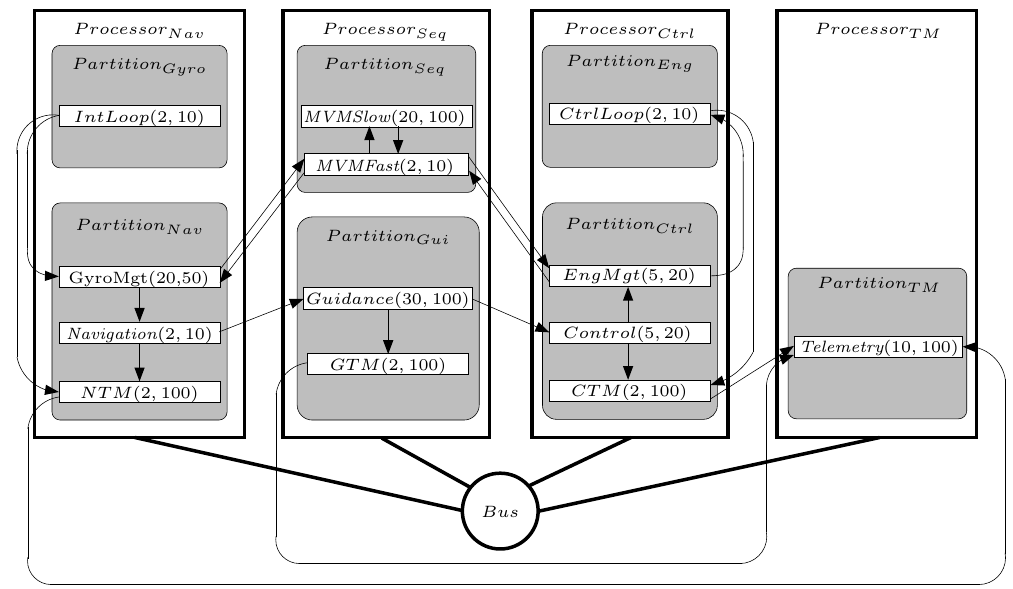
Figure 13 Architecture, partitioning and task allocation for the large-scale model of the space launcher. The two integers inside each task define its duration and period (in